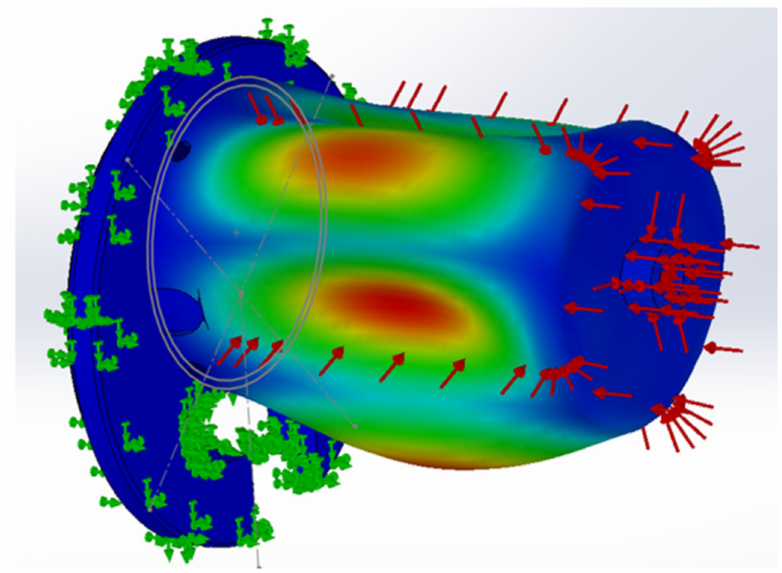
Figure 11. FEM simulation of the sea pressure on the rolling diaphragm cylinder—stress results.